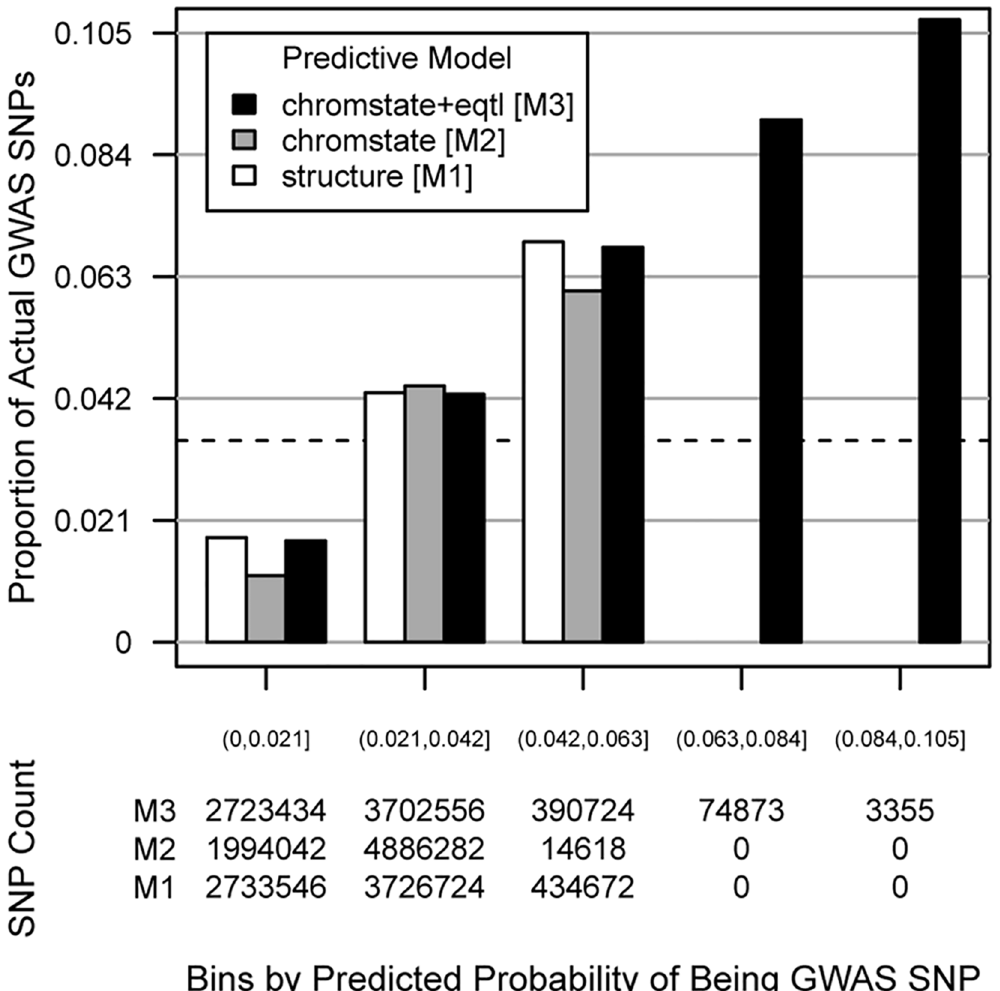
Fig 5. Multivariate logistic models predicting SNP membership in GWAS are well-calibrated. Top panel: Three models were developed for predicting the membership of a given SNP in the NHGRI GWAS Catalog, all incorporating at minimum the distance of the SNP from the transcript boundaries of its target gene and the minor allele frequency of the SNP. The "structure [M1]" model (white) also incorporates the NCBI gene structure classification of the gene (intron, coding, untranslated region, etc.) (S2 Fig); "chromstate [M2]" (gray) instead incorporates chromatin state (S2 Fig); "chromstate+eqtl [M3]" (black) incorporates both chromatin state and eQTL FDR class (Fig 4). The x -axis shows equal-sized bins of predicted probabilities of being a GWAS SNP. This particular choice of bins based on the widest range of probabilities (from M3) aids visual comparison of calibration among the three models by smoothing the proportions of observed GWAS SNPs. The y -axis shows the actual proportion of GWAS SNPs in that bin. The dashed green line at 3.5% represents the mean probability of a random SNP in the genome for being a GWAS hit or a close proxy ( r 2 > 0.8) for one. Bottom panel: a table of absolute counts of SNPs in each predicted probability bin for each of the predictive models. For the M1 and M2 models, no SNPs had predicted probabilities >